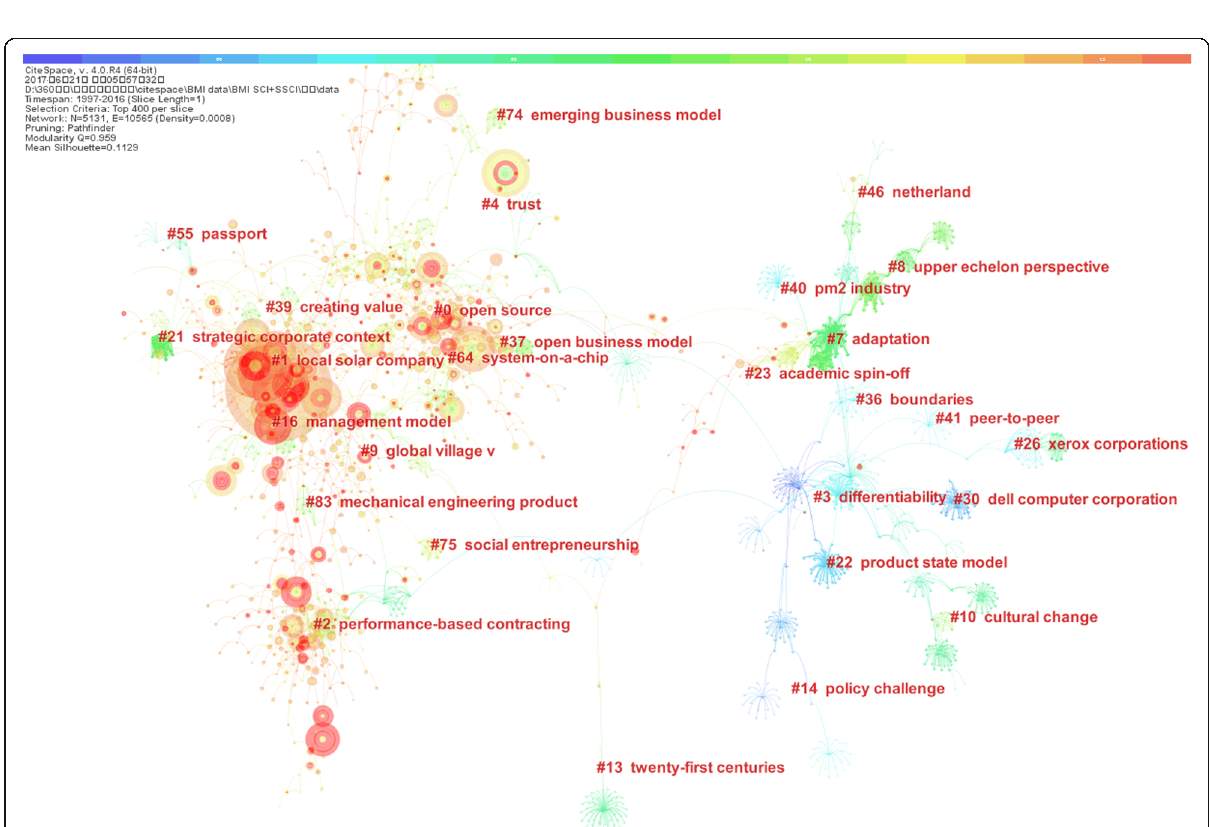
Fig. 5 The literature co-citation map of the extended dataset based on LLR